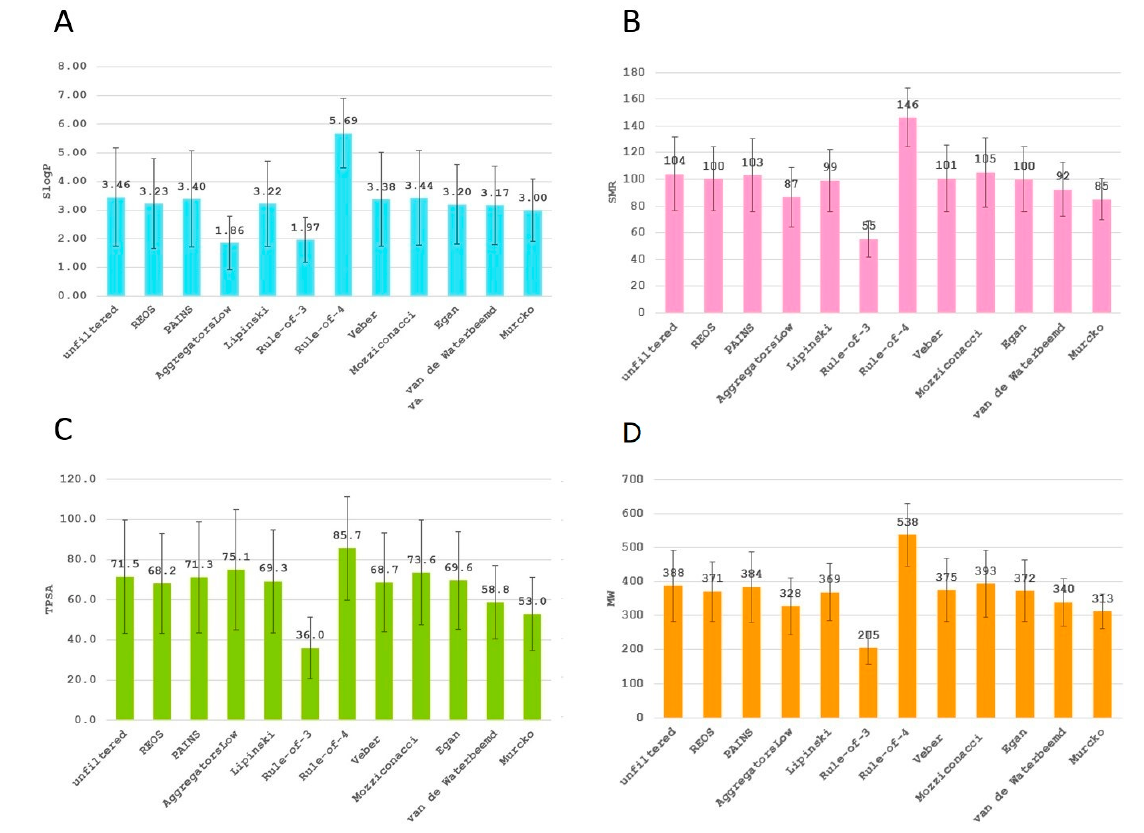
Figure 2. ( A ) The average descriptor value with SD of SlogP for the unfiltered and post filtering libraries. The majority of the filters have values close to the average, with AggregatorsLow and Rule-of-3 scoring lower, since they have strict cut-off values for SlogP. The partition coefficient is used to assess the lipophilicity of a drug and its ability to cross cell membranes. ( B ) The average descriptor value with SD of SMR for the unfiltered and post filtering libraries. The clear outliers are the Ro3 and Ro4, which strictly define the chemical space. ( C ) The average descriptor value with SD of TPSA for the unfiltered and post filtering libraries. The Ro3 with molecules small in size scores lower than the average, with the Ro4 being slightly above the average, but not as significantly as in the previous graphs. ( D ) The average descriptor value with SD of MW for the unfiltered and filtered libraries. The molecular weight descriptor is a very common descriptor used for cut-off values. As most of the filters aim at drug-like molecules except for the Ro4 and Ro3, the average weights are very similar.